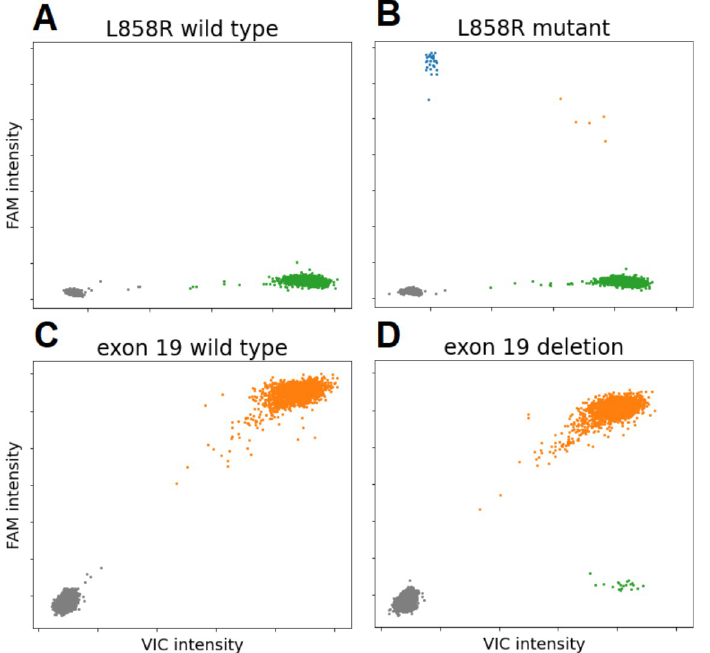
Fig 2. Droplet digital PCR test for EGFR L858R for wild type DNA (A) and mutant EGFR L858R DNA at 1% variant allele fraction (B). EGFR exon 19 deletion analysis for wild type DNA (C) and mutant EGFR E746_A750del at 1% variant allele fraction